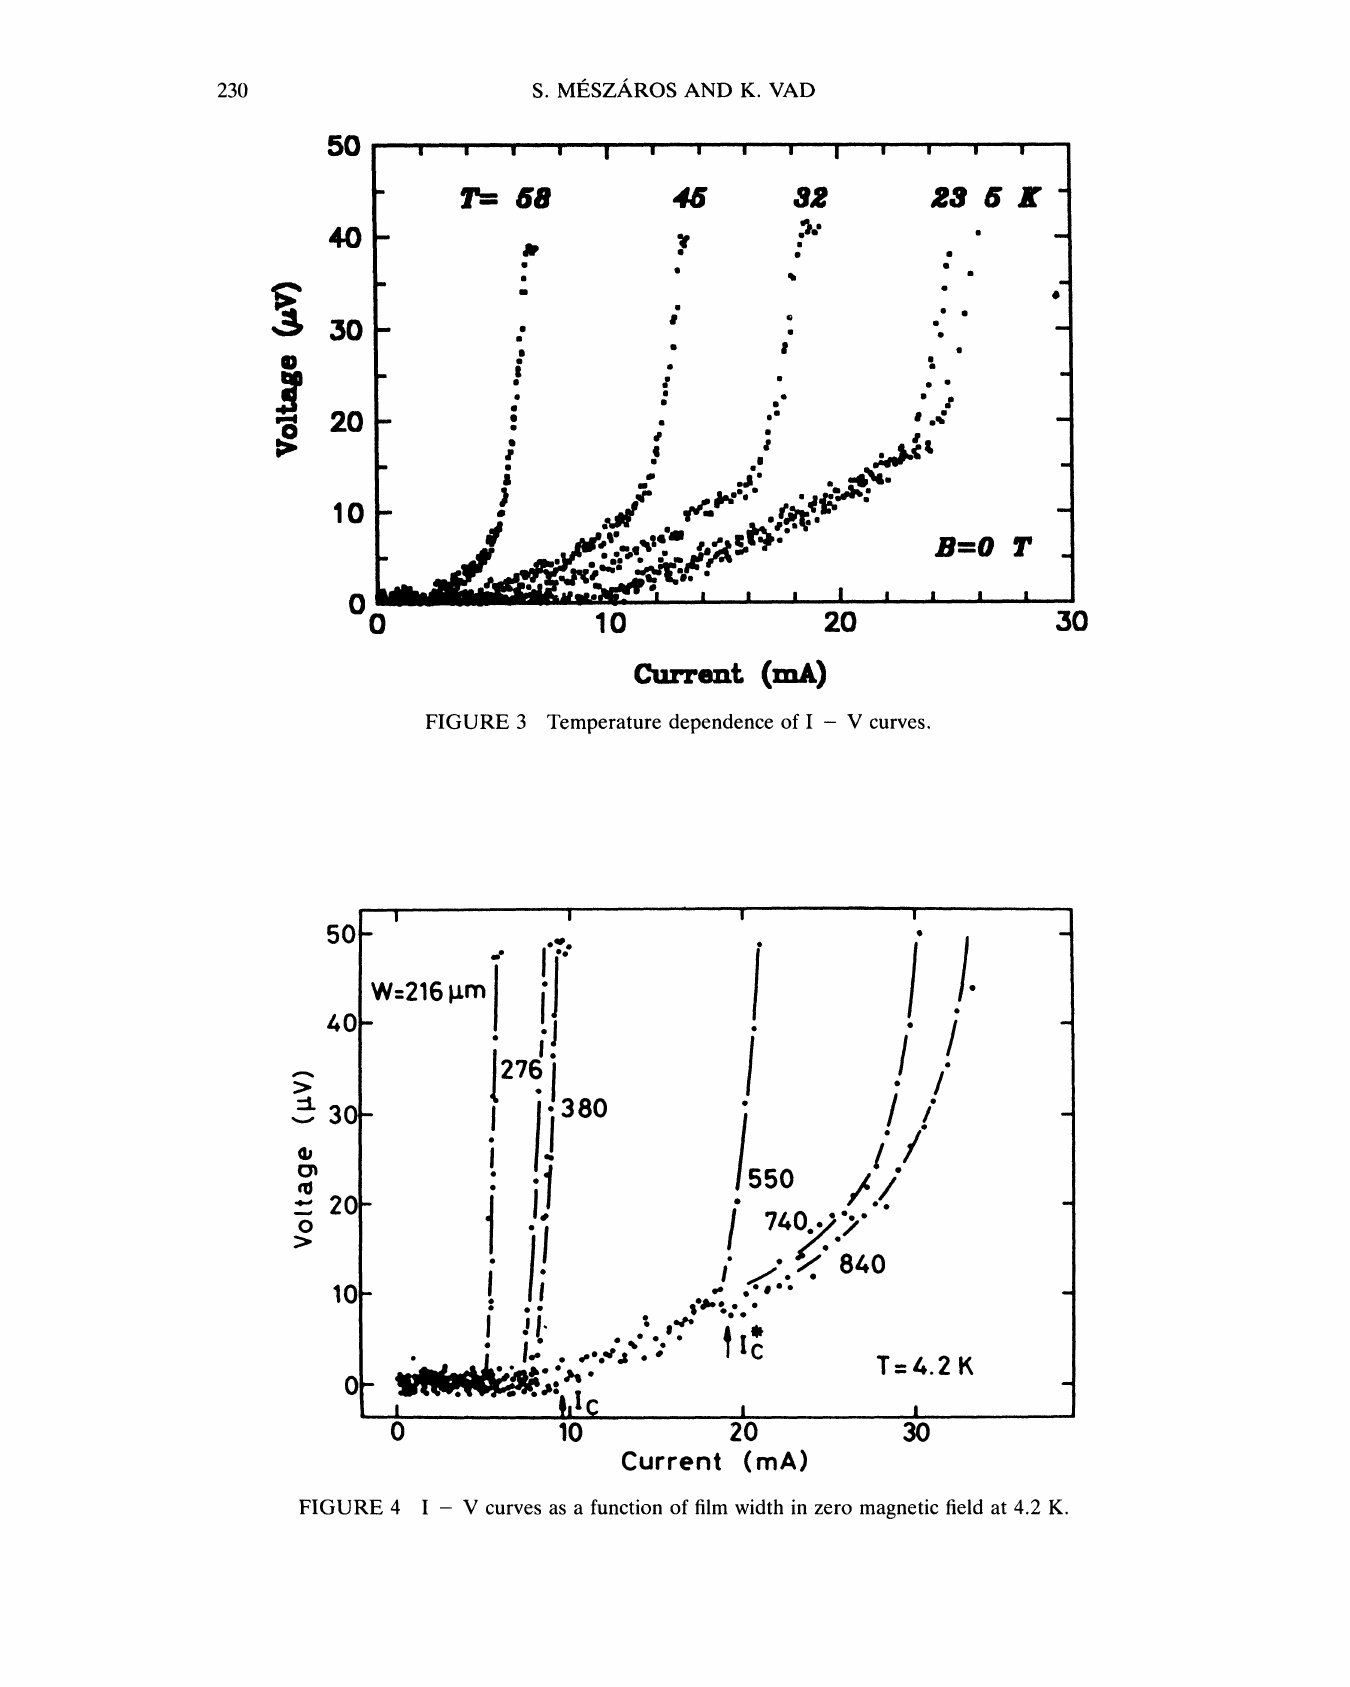
FIGURE 4 V curves as a function of film width in zero magnetic field at 4.2